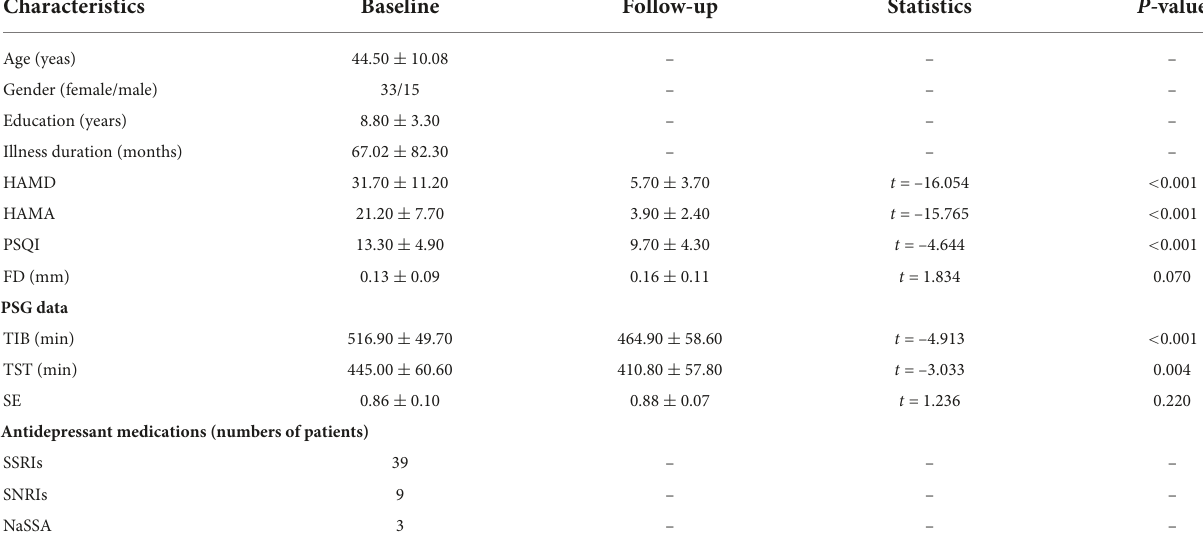
TABLE 1 Demographic, clinical, and PSG characteristics of the sample.